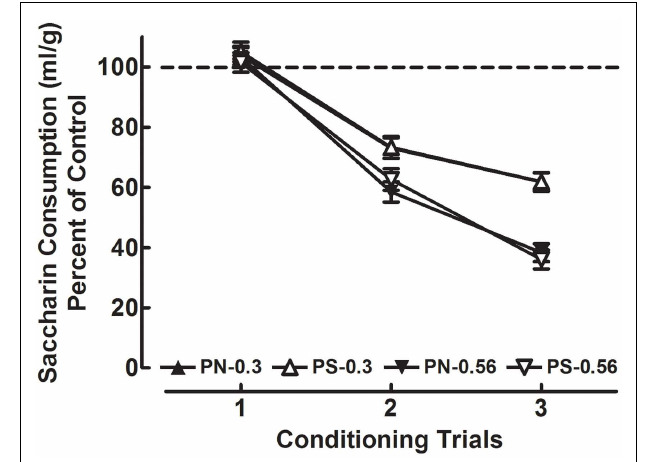
FIGURE 3 | Mean ( ± SEM) percent of control saccharin consumption (ml/g) data from the acquisition phase of the experiment. The CS was saccharin (0.1%, w/v) and the US was METH (SAL, 0.3 or 0.56mg/kg). Data are shown as percent of control for the PS and PN animals treated with METH across conditioning days 1–3.There were no significant effects or interactions with the factor of PrenatalTreatment or